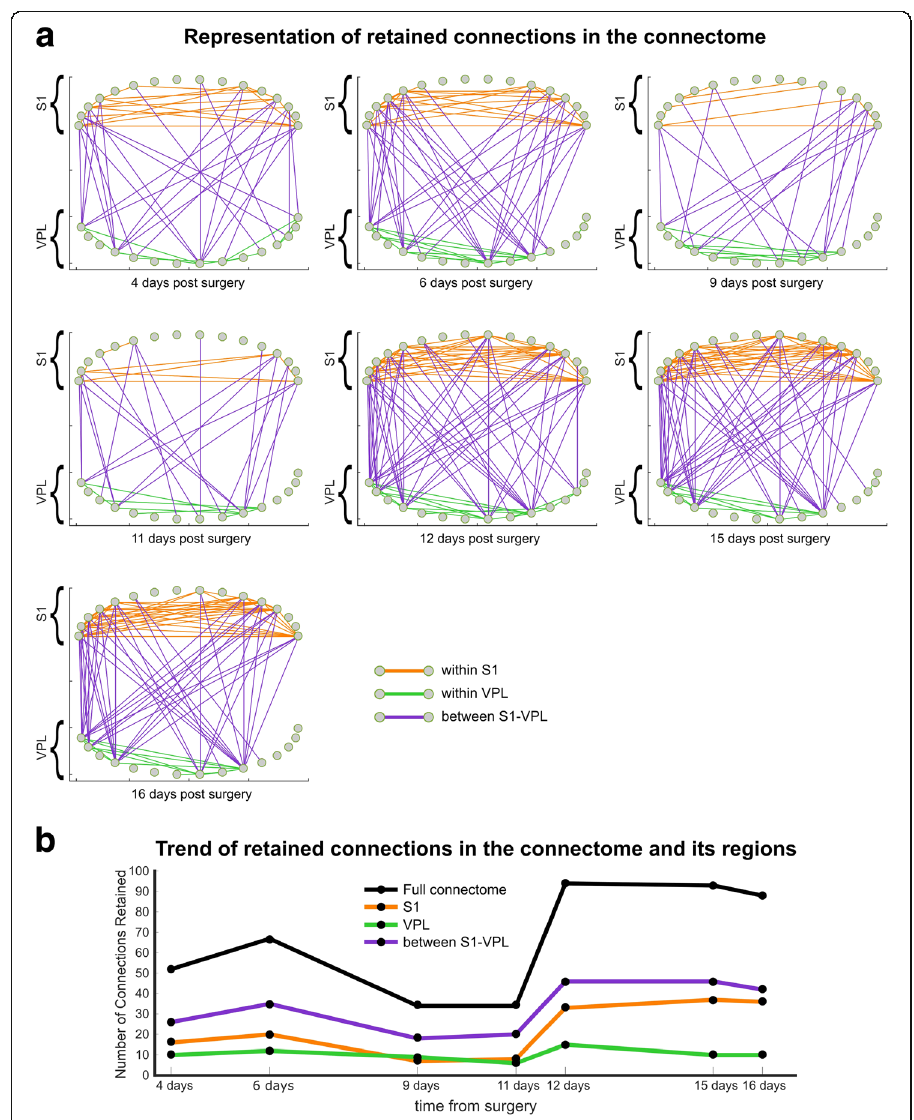
Fig. 6 a Network representation of the connections retained between consecutive time steps, within S1 ( orange ), within VPL ( green ) and between S1-VPL ( purple ). E.g. 3 h/4d point represents the connections retained from time step of 3 h to 4 days post surgery. The density of the links is representative of the stability of the connectivity in the time interval. A lower density is noticed from 3 h/4d to 9d/11d and in particular at 6d/9d and 9d/11d, in fact the central intervals 4d/6d – 6d/9d and 6d/9d - 9d/11d are the ones that exhibit the highest change in the number of intra-regional links as highlighted in Fig. 5b. Instead, the final time intervals (from 11d/12d to 15d/16d) show higher density and therefore greater stability. b Plot of the number of retained connections within the full connectome, within S1, within VPL and between S1-VPL. Retained links represent maintained communication. A permanent engram associated with chronic pain memory seems to appear and maintain its architecture in the entire S1-VPL region starting from the 11th